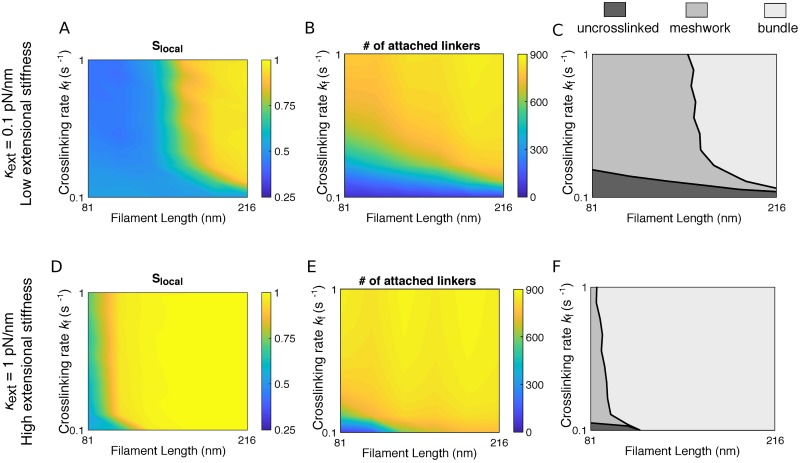
Phase diagram of actin network organization as a function of the crosslinking rate kf and filament length L.(A, D) Local nematic order parameter Slocal as a function of kf and L. (B, E) Number of attached crosslinkers Nattach as a function of kf and L. (C, F) Classification of actin network organizations as a function of kf and L. The extensional stiffness κext is 0.1pN/nm in panels (A-C), and 1pN/nm in panels (D-F). In panels (A, B, D, E), plots are constructed by interpolation of results obtained for increment ΔL = 27nm of L between 81nm and 218nm, and increment Δkf = 0.1s−1 of kf between 0.1s−1 and 1s−1. The value for each parameter set is an average over 10 simulations. In (C) and (F), the border separating bundle (light gray) from meshwork (gray) is defined by Slocal = 0.75. The border separating meshwork (gray) from uncrosslinked (dark gray) is defined by Nattach = 300.